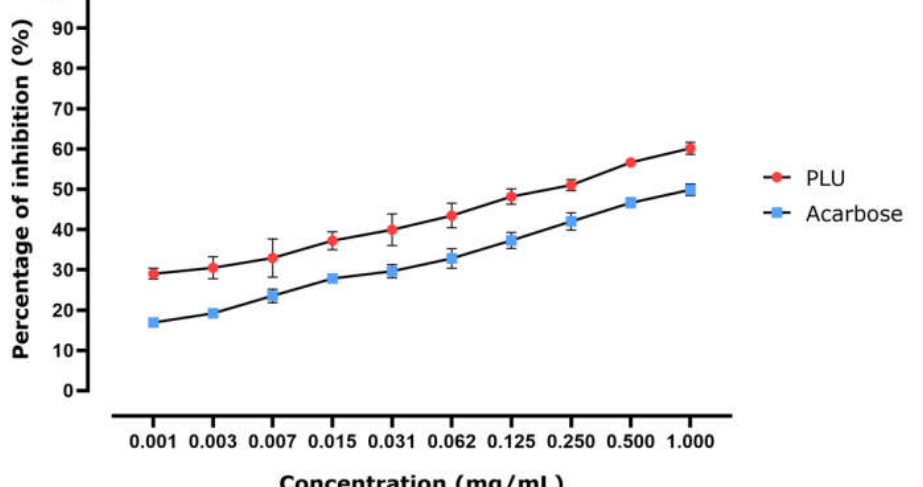
Figure 4. In vitro α-amylase inhibitory activity in response to PLU and acarbose represented as percentage of inhibition of the enzyme activity.